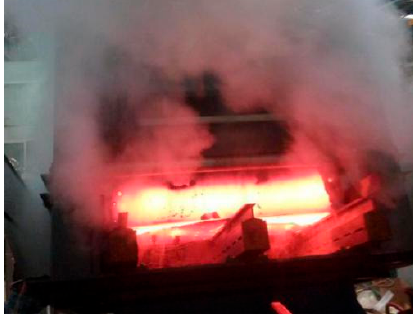
Figure 7. Slab cooling process.